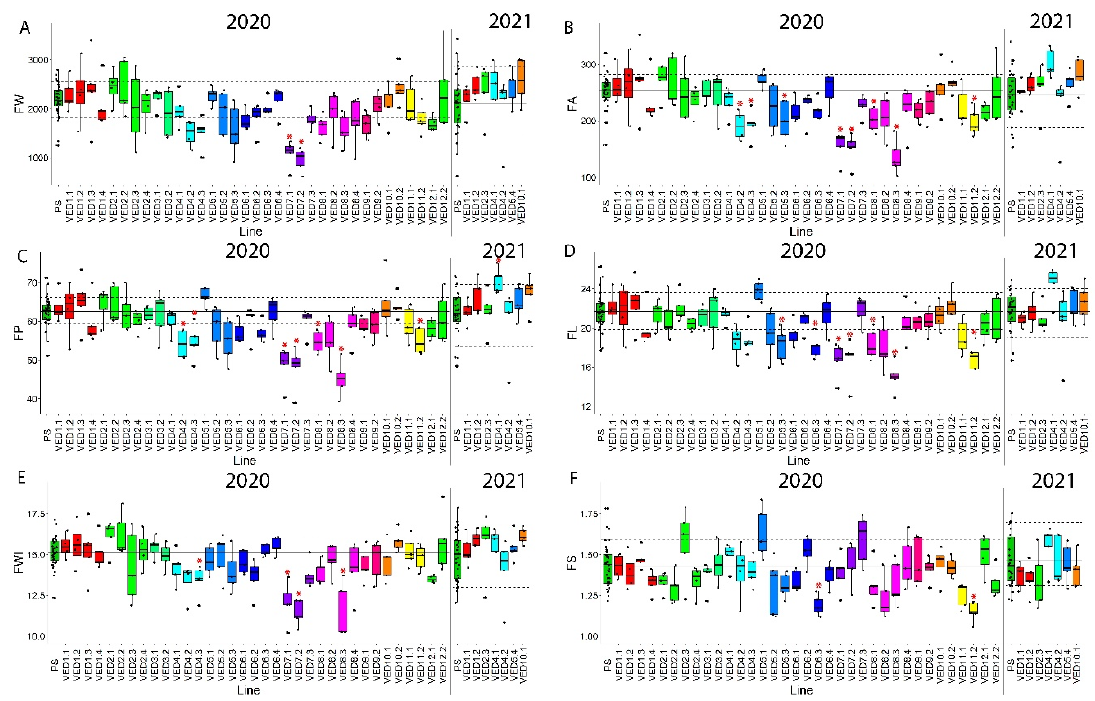
Figure 5. Fruit-morphology-related phenotypes of the population in both years 2020 and 2021. Replicates are represented with dark circles. Red asterisk indicates p -value < 0.05 and different colors indicate different chromosomes. ( A ) Fruit weight (FW) in grams. ( B ) Fruit area (FA) in squared centimeters (cm 2 ). ( C ) Fruit perimeter (FP) in cm. ( D ) Fruit length (FL) in cm. ( E ) Fruit width (FWI) in cm. ( F ) Fruit shape (FS).